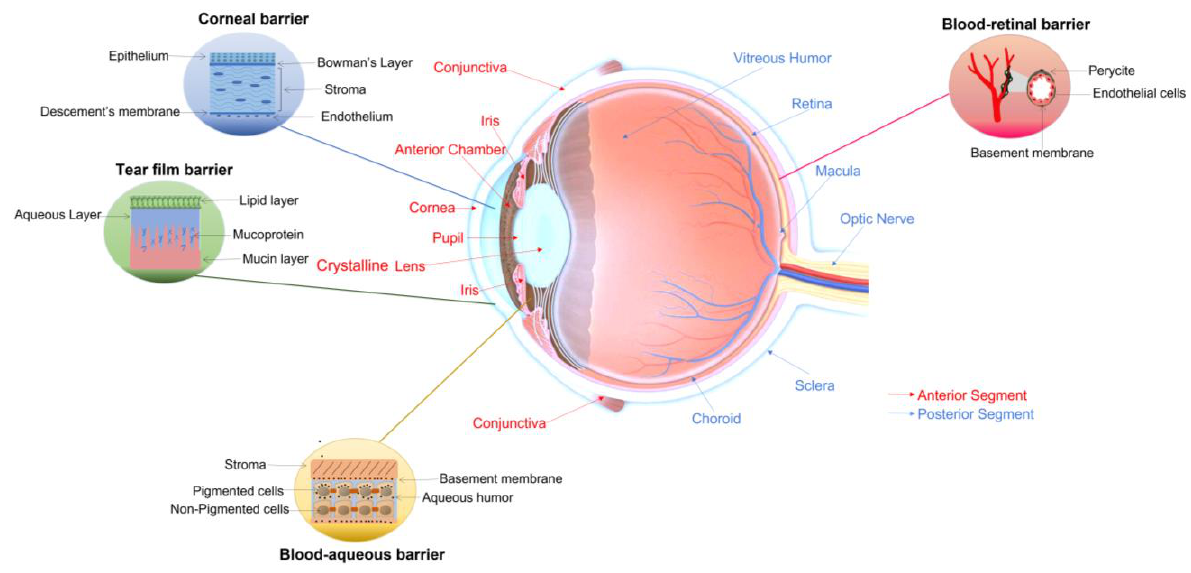
Figure 1. Schematic representation of the eye anatomy. In red are indicated the specific structures located in outer anterior segment, in blue the components of the posterior compartment, and in black the main ocular barriers present in the eye.